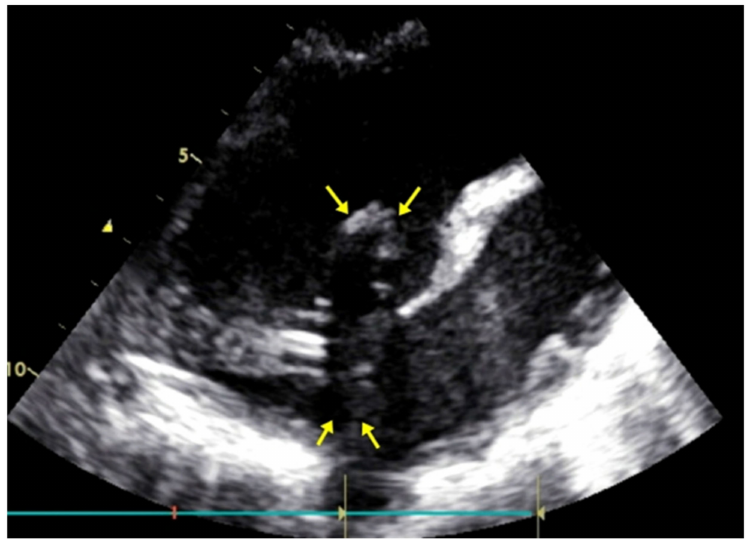
Figure 2. Representative case of echocardiography. Echocardiography was used to verify the position of the spacer